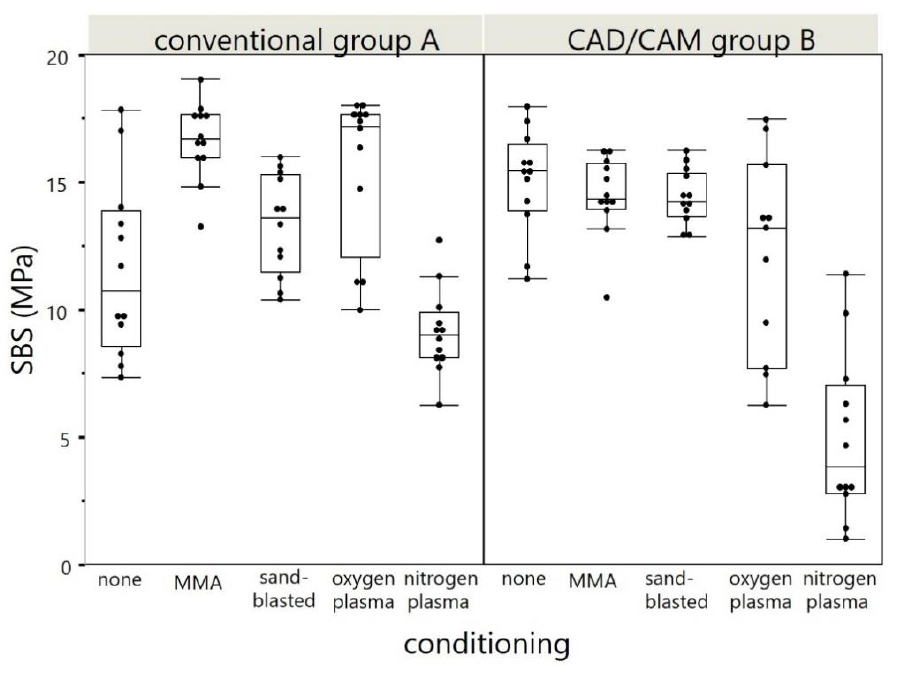
Figure 8. Boxplots of the shear bond strength (SBS) values for the Groups A and B. The data are derived from n = 12 specimens per mechanical test depending on each conditioning ( x -axis).